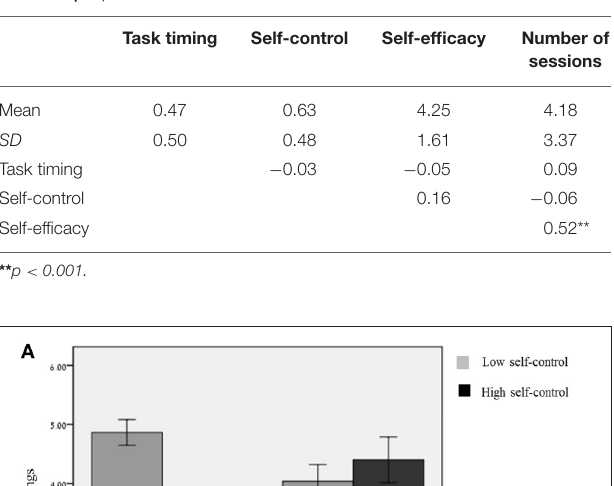
TABLE 2 | Experiment 2.